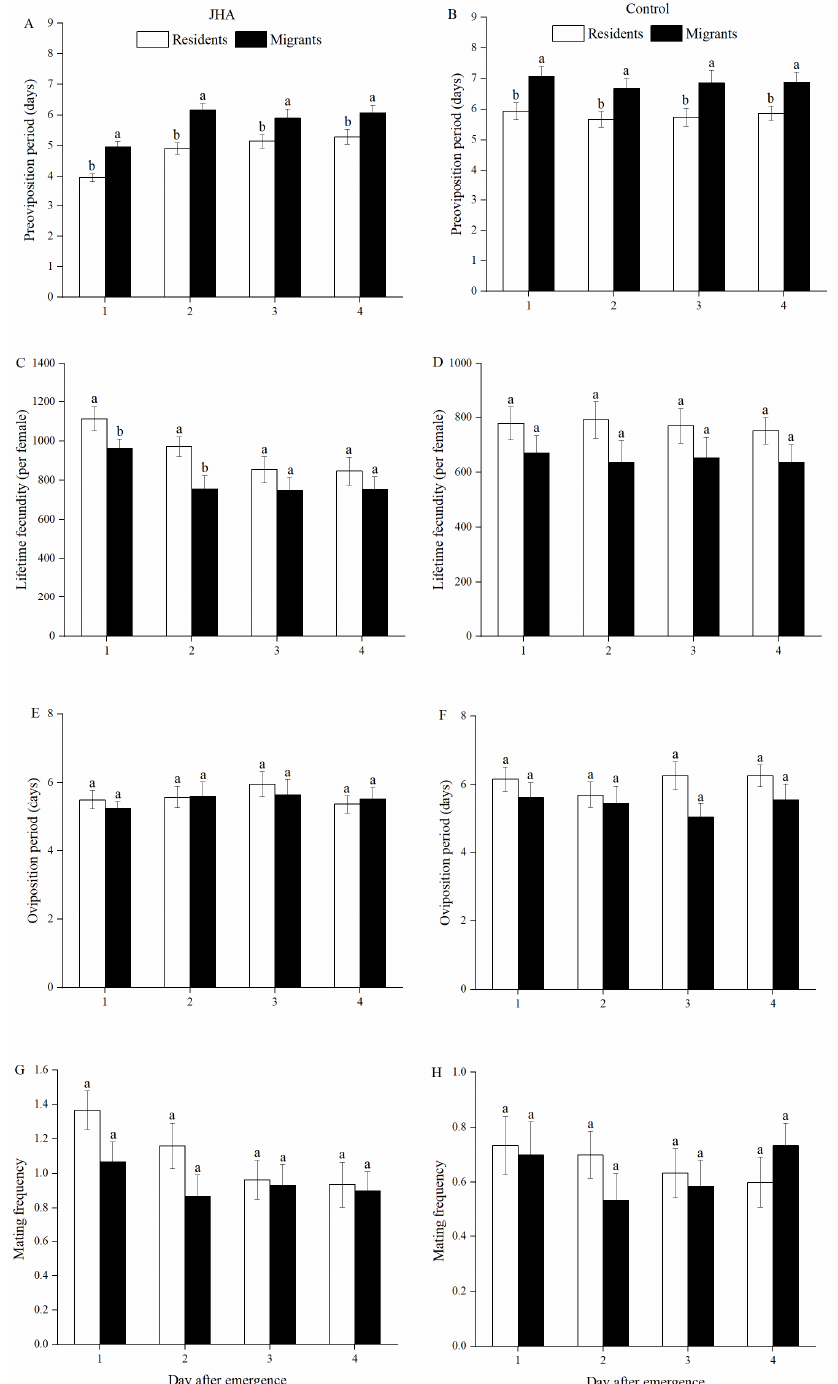
Figure 1. Pre-oviposition period ( A : JHA, B : Control), lifetime fecundity ( C : JHA, D : Control), oviposition period ( E : JHA, F : Control) and mating frequency ( G : JHA, H : Control) of M. separata between residents and migrants exposed to JHA at various ages. Different lowercase letters above group bars represent significant differences between residents and migrants at the 5% level by Tukey’s HSD test. Sample sizes for each JHA treatment (left to right), residents: 30, 31, 26 and 29 pairs; migrants: 30, 30, 29 and 30 pairs. Sample sizes for each control treatment (left to right), residents: 30, 30, 30 and 30 pairs; migrants: 30, 28, 29, and 30 pairs.